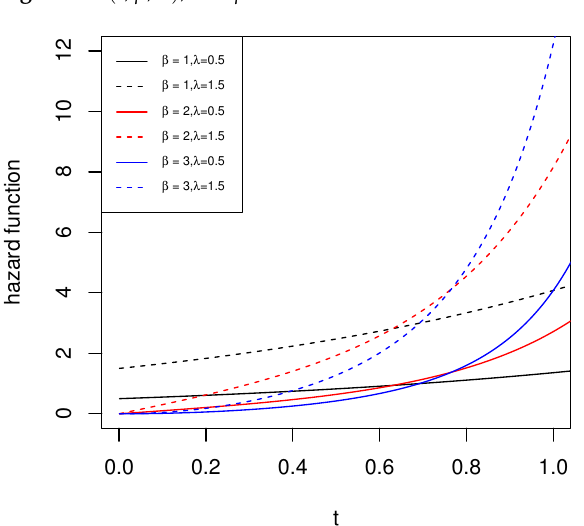
Figure 6. h ( t ; β , λ ) , β ≥